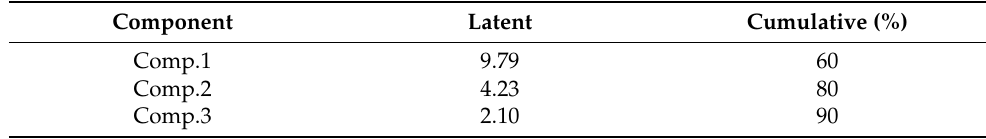
Figure 6. Results of the PCA. Table 2. Latent and cumulative scores for PCA. Component